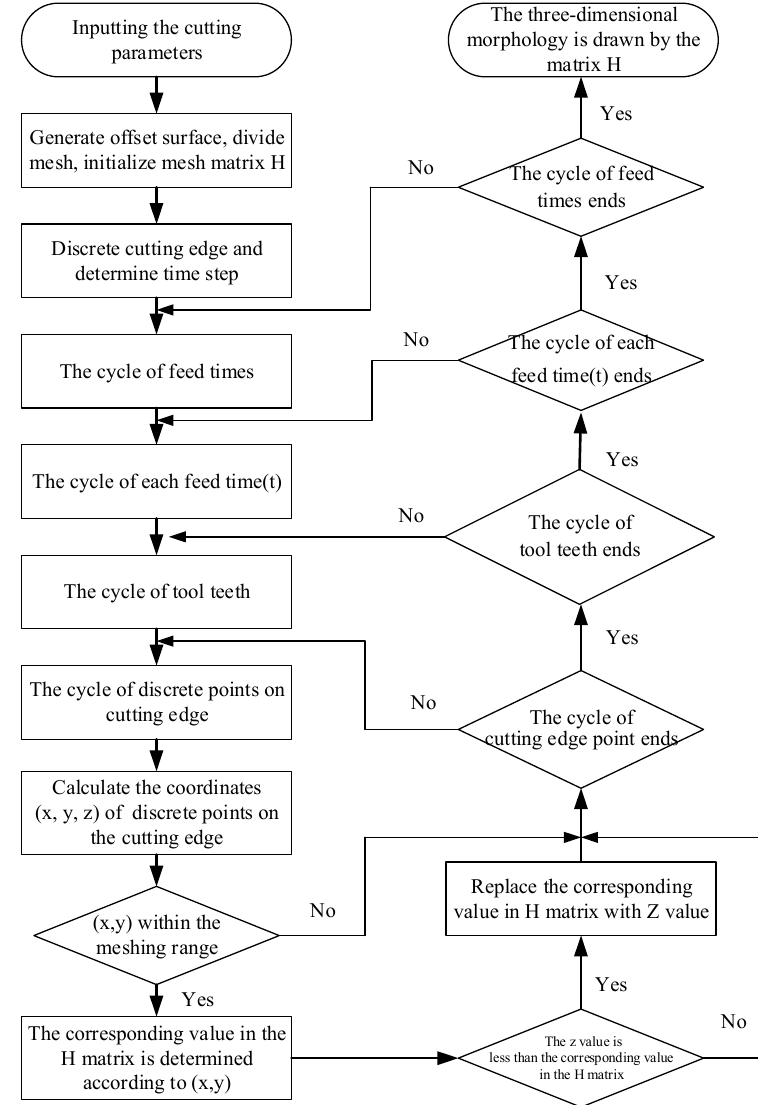
Figure 5. The detailed algorithm flow chart.